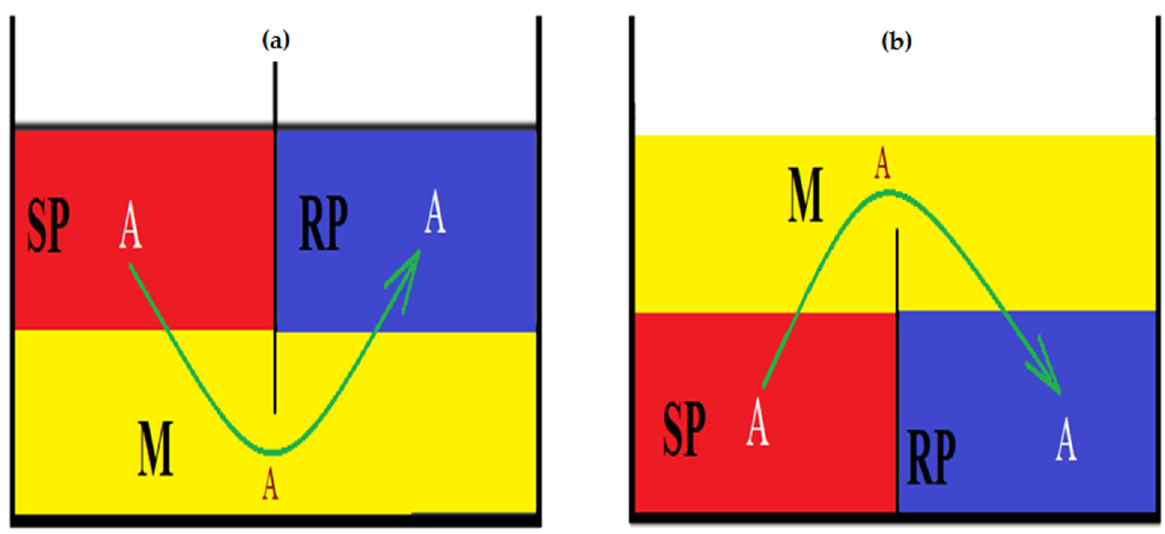
Figure 1. Schematic representation of membrane systems with an organic solvent: ( a ) denser or ( b ) less dense than the aqueous phases. Legend: M = membrane; SP = Source Phase; RP = Receiving Phase; A = interest chemical species for separation.